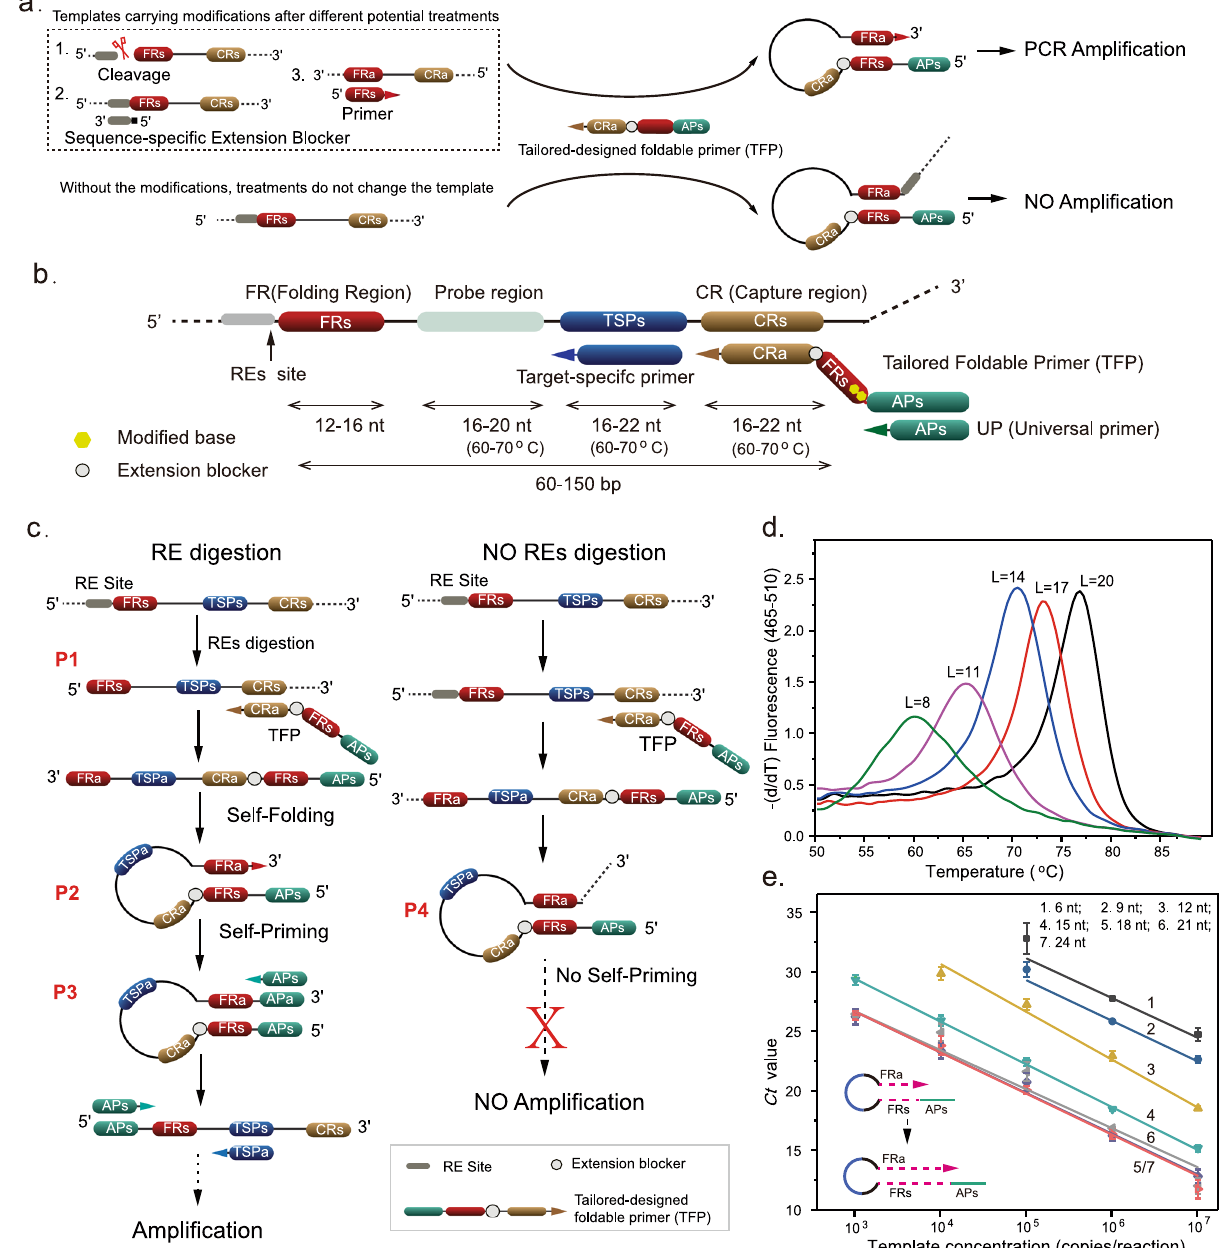
Fig.1|STEM-PCRforlocation-speci fi cmethylationdetection.a Themechanism of STEM-PCR with different template strategies. The extension blocker is PEG18, equivalentto6ntinlength 31 ,notedasiSp18inSupplementaryTables1 – 7. b STEM- PCR ampli fi cation primer design showing the recommended distance between primerregionsandameltingtemperature(Tm)rangeforeachprimer.Primersare indicated by solid arrows and given the corresponding capital letter designation. c The mechanism of STEM-PCR for RE digestion mediated location-speci fi c detection. The lower-case letter s/a indicates the sense and antisense of the sequence; d DNA melting for different sequence lengths, L, of the stem from 8